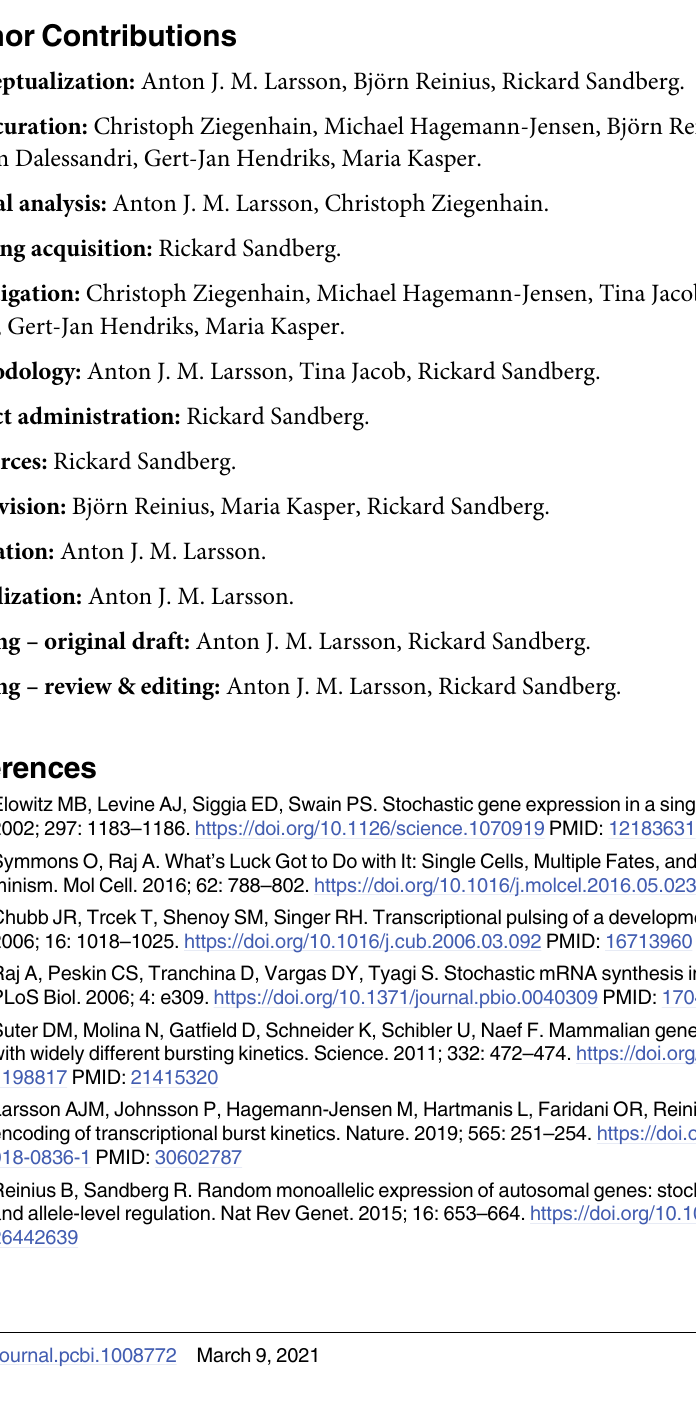
S2 Table. Predicted probabilities, observed fractions and mean expression for all genes used in the analysis. Analysis code is also available at https://github.com/sandberg-lab/